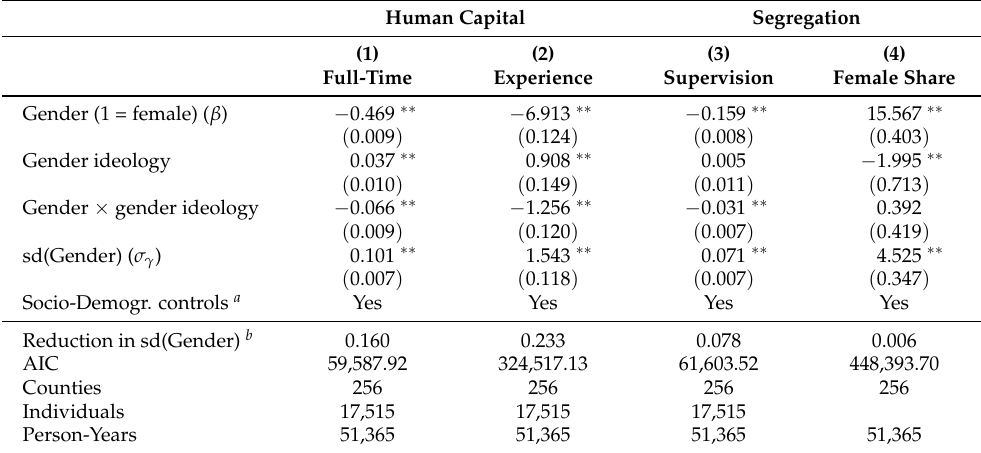
Table 1. Multi-level Models Predicting Gender Disparities in Wage-Determinants by Gender Ideologies. Human